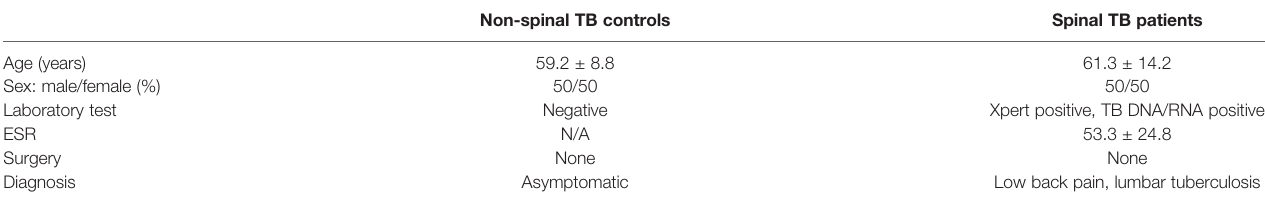
TABLE 1 | Baseline characteristics of the study